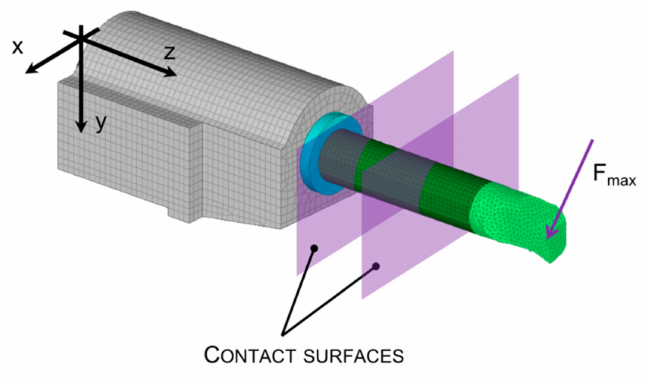
Figure 13. Boring bar model for slots surfaces distancing estimation.